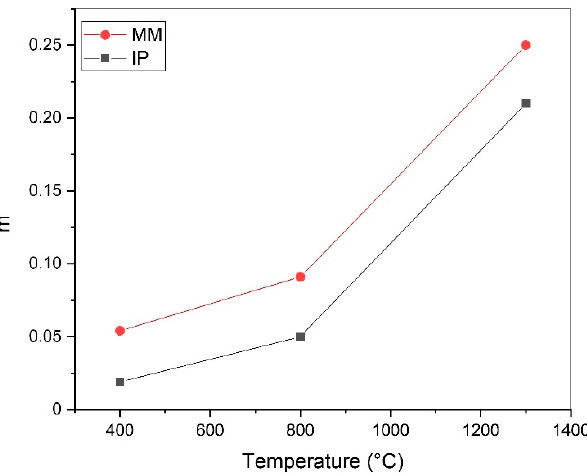
Figure 9. Strain rate sensitivity vs. the temperature of the two materials at ε = 0.05.